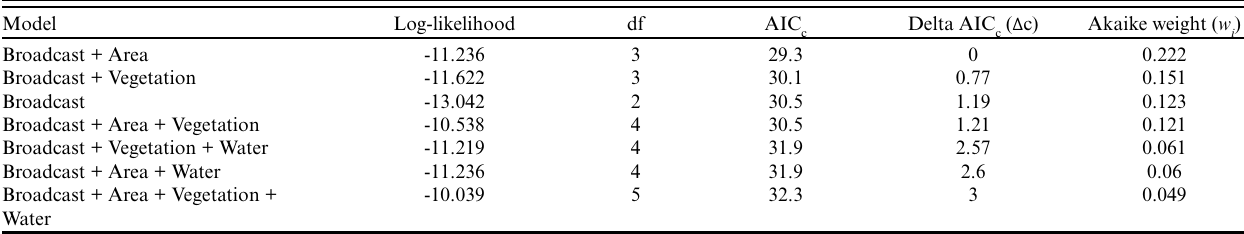
Table 4. Top ranked logistic regression models (< 2 Δ AIC